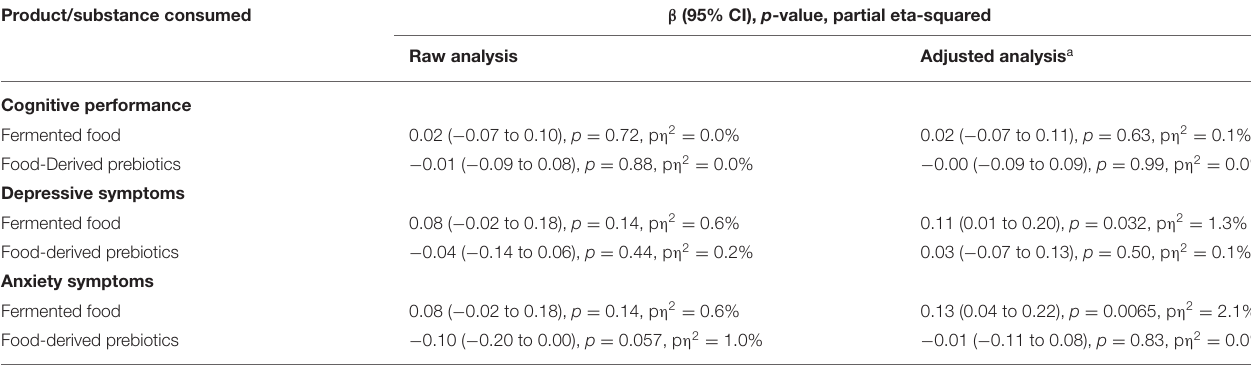
TABLE 3 | The association between consumption of fermented food and food-derived prebiotics with cognitive performance, depressive, and anxiety symptoms under psychological stress ( n = 372). Product/substance